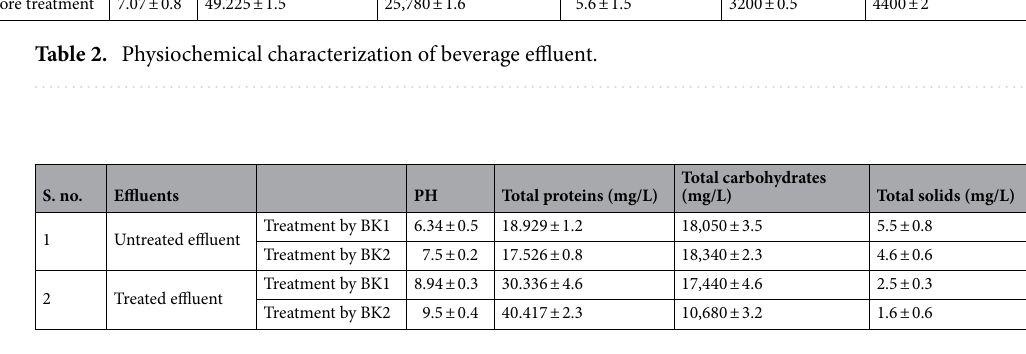
Table 3. Characterization of effluent after removal by BK1 and BK2.